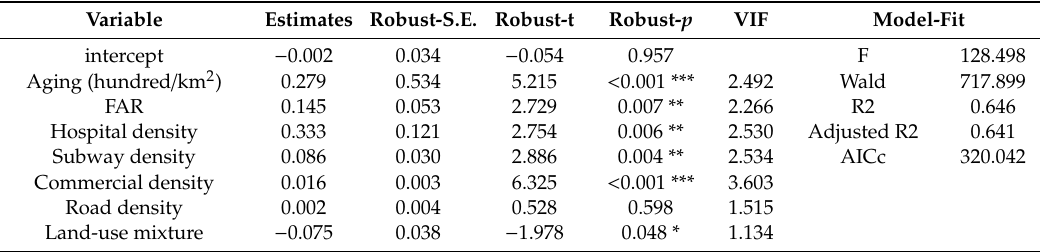
Table 3. OLS model results.